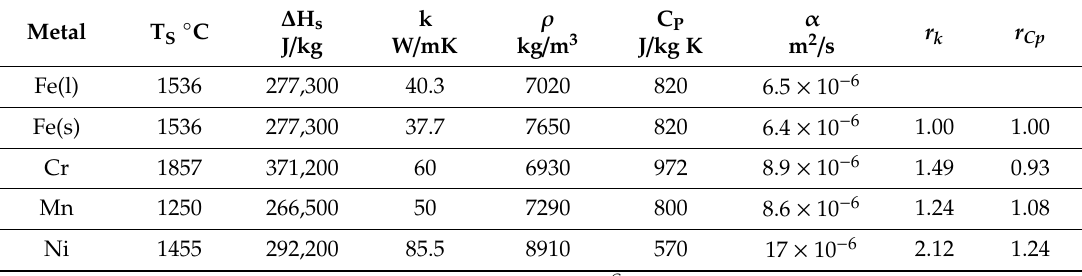
Table 4. Physical properties of metals